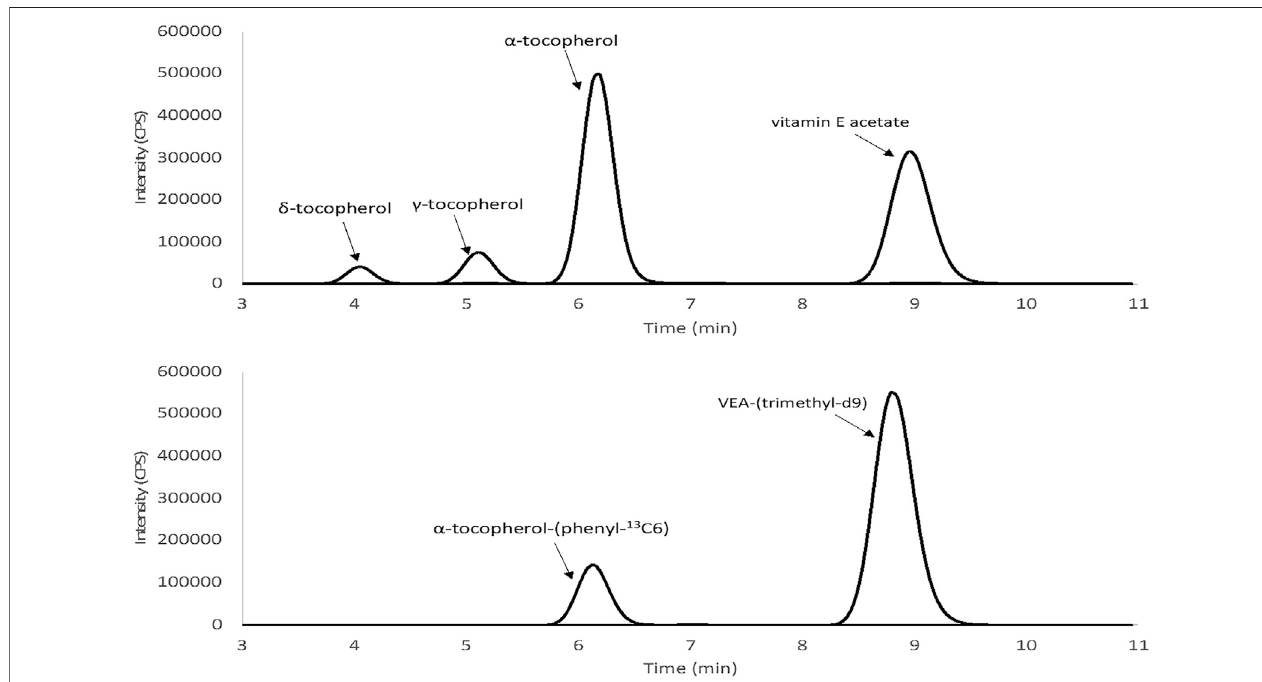
FIGURE 1 | Representative chromatograms of vitamin E acetate (VEA) and other tocopherols spiked into emissions of simulated EVP liquid: (Top) VEA and other tocopherols combined quantitation transitions (500 ng/ml) (bottom) labeled α -tocopherol (200 ng/ml) and deuterated VEA (200 ng/ml).